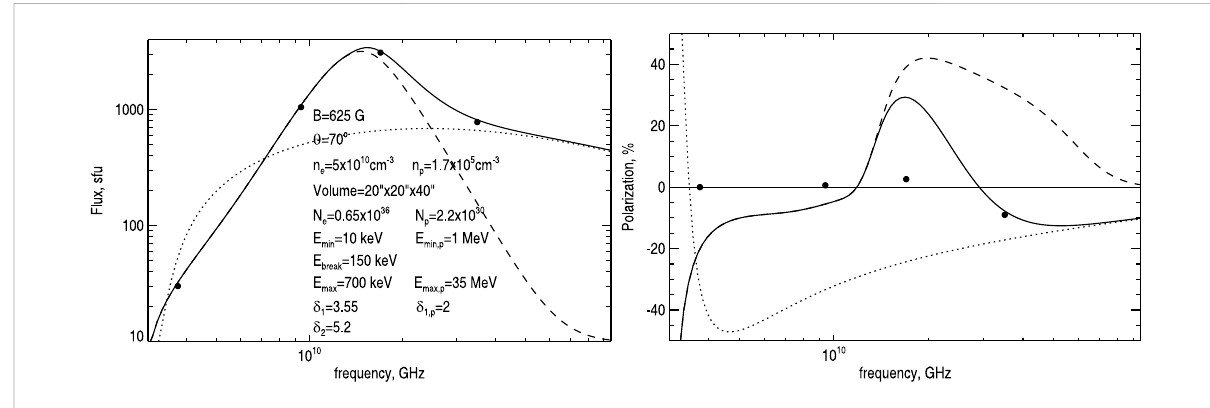
FIGURE 3 Microwave observations and a single-zone GS model (parameters of the model are printed in the left panel) for the 2000 March 13 event. The broken power-law spectrum of the nonthermal electrons is taken from Gan et al. (2001) derived from analysis of the HXR spectrum. The magnetic fi eld value and the source dimensions are taken such as to match the low-frequency measurements. The resulting microwave spectrum (dashed curve) underestimates theemission athigh frequencies. Adding emission produced by arelativistic positron component (dotted curve)offers a good matchatall frequencies.Notethat these two components are optically thinat high frequencies, so thecontributions add up,while theopacity at tlow frequencies is solely determined by the electron contribution, so the positron component has no effect on the total spectrum at the low frequencies. The model also offers a correct sense and value of the polarization at the highest frequency, 35 GHz (see text for the